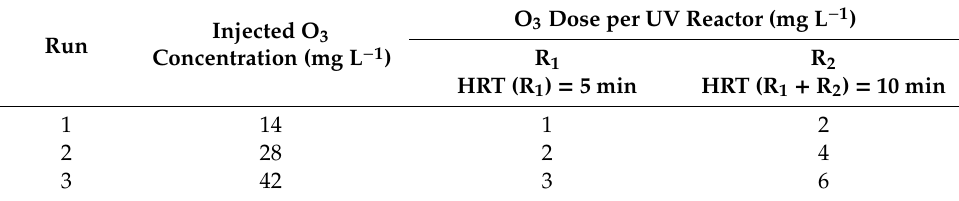
Table 1. Ozone dose applied to the O 3 / UV 65W